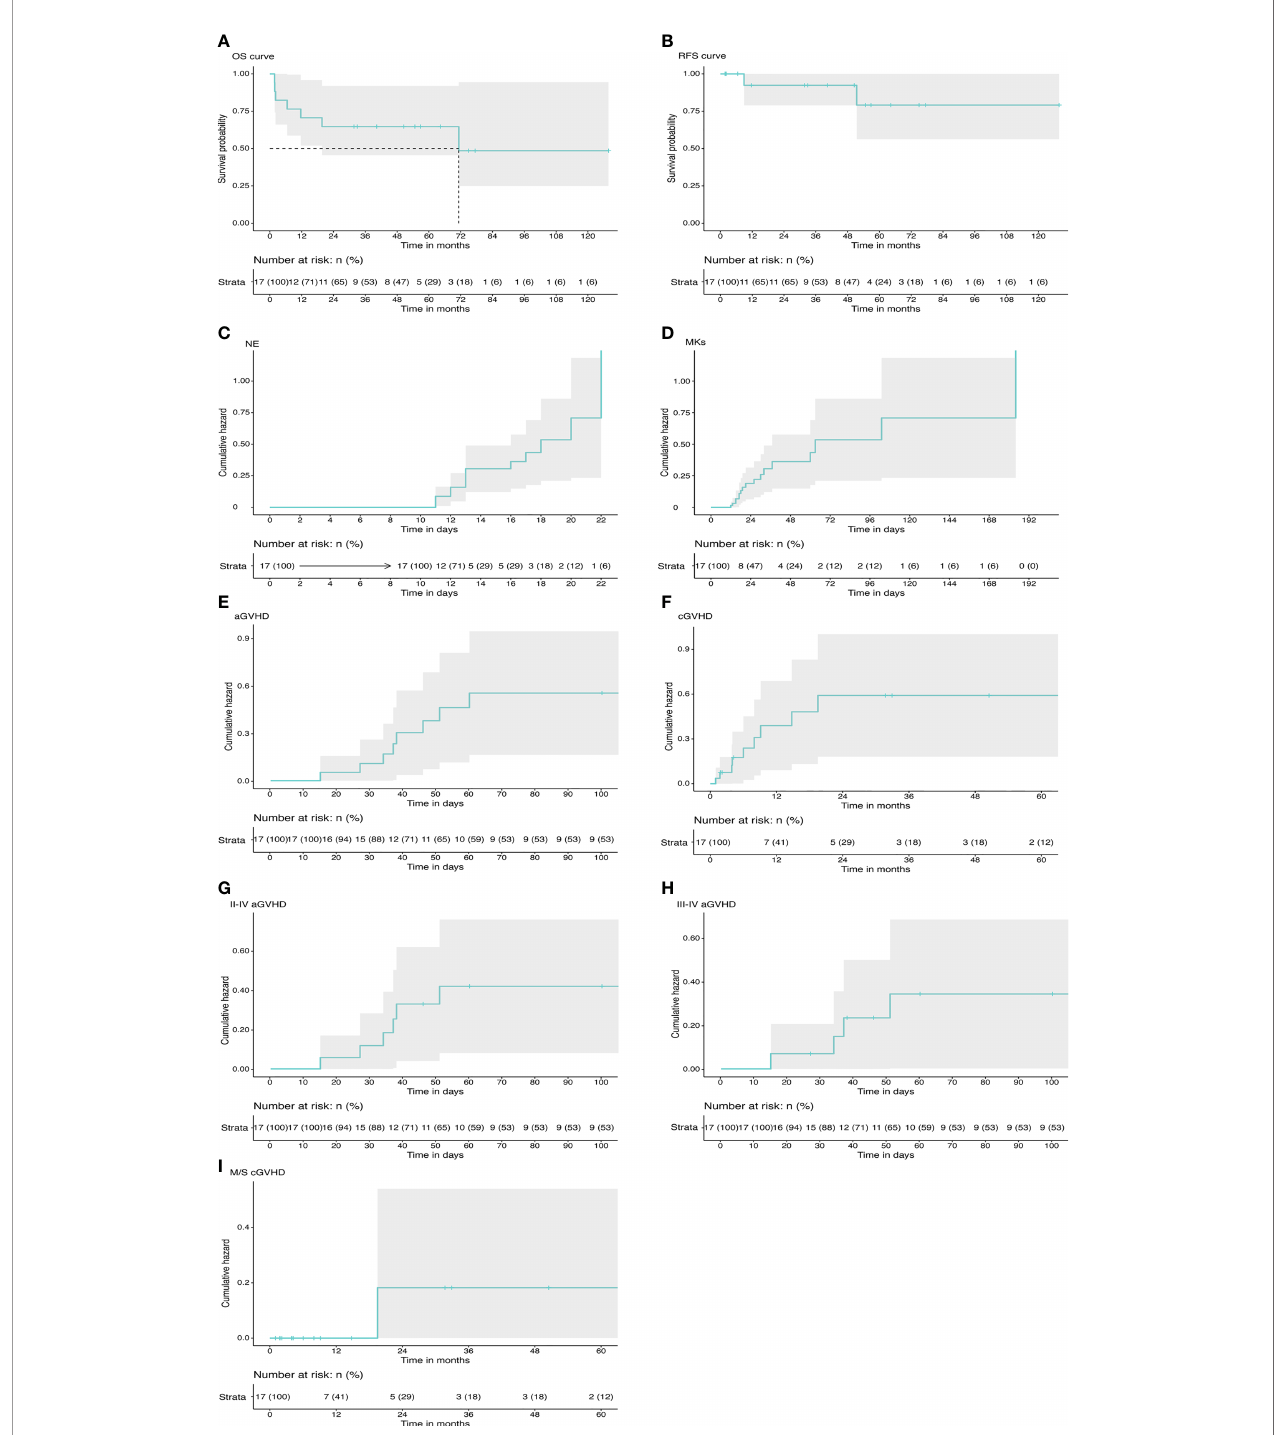
FIGURE 1 | Transplant outcomes in primary myelo fi brosis. (A) The probability of OS. (B) The probability of RFS. (C) The cumulative incidence of neutrophil engraftment. (D) The cumulative incidence of platelet engraftment. (E) The total cumulative incidence of aGVHD. (F) The total cumulative incidence of cGVHD. (G) The cumulative incidence of grade II – IV aGVHD. (H) The cumulative incidence of grade III – IV aGVHD. (I) The cumulative incidence of moderate to severe cGVHD. OS, overall survival; RFS, relapse-free survival; NE, neutrophil; MK, megakaryocyte; aCVHD, acute graft-versus-host disease; cGVHD, chronic graft-versus-host